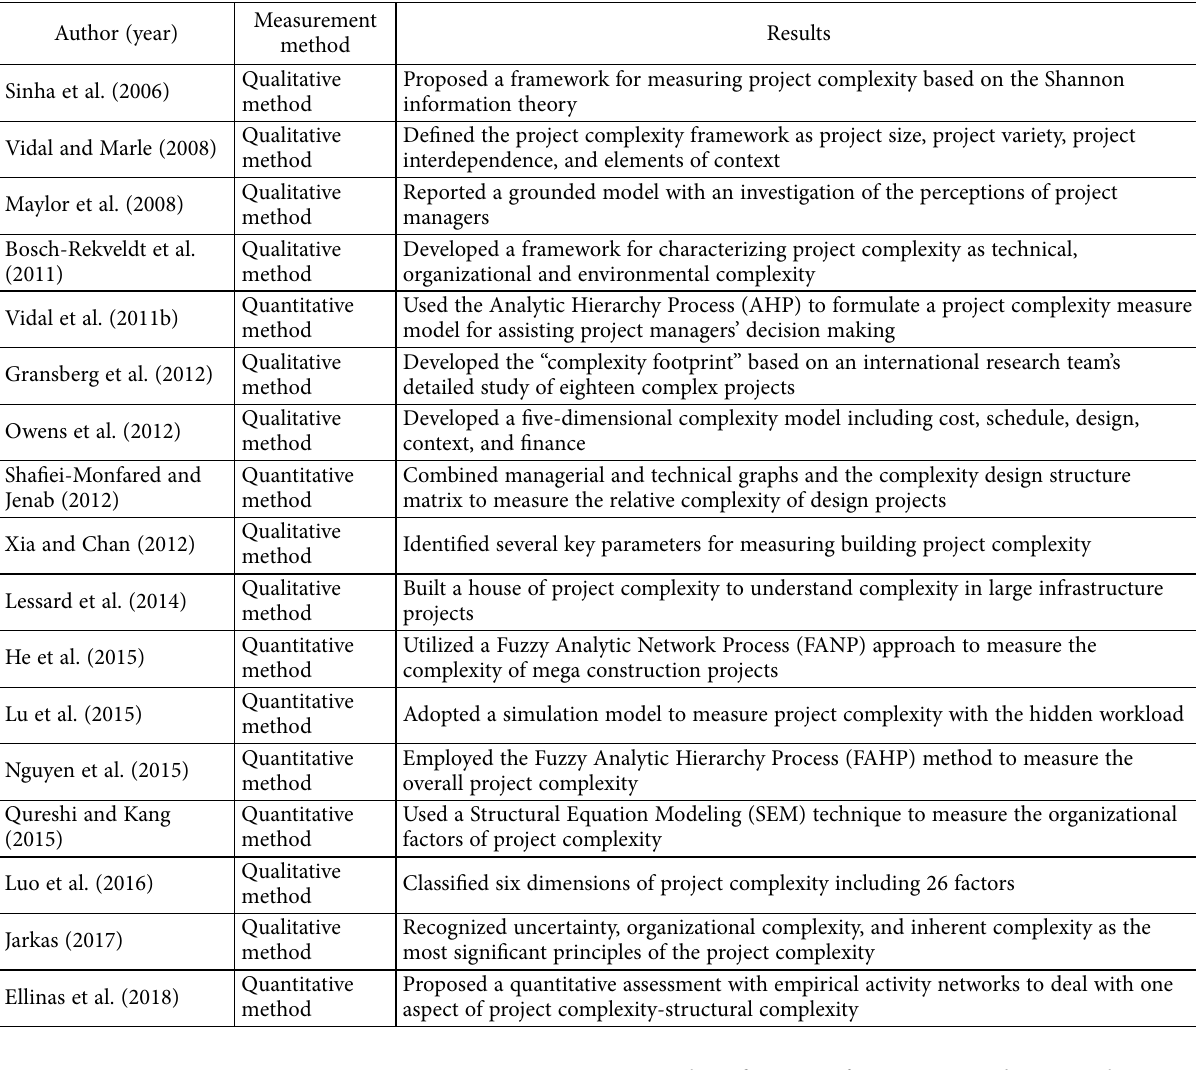
Table 1. Literature review on project complexity measurement